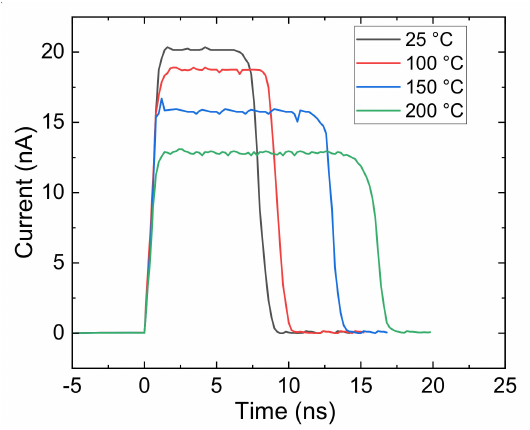
Figure 25. Example of TCT pulse measured at increasing temperature. The pulse reduces in ampli- tude but enlarges in the time, resulting in an almost constant collected charge up to the maximum temperature at which the detector operates in stable